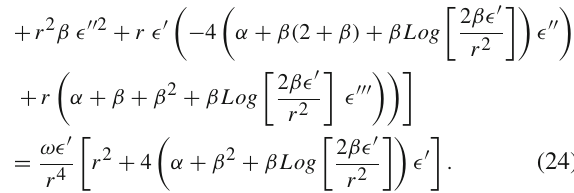
responding regions. It is clear that at the throat ρ < 0, ρ + p r < 0 and ρ + p > 0, but outside the throat ρ > 0, ρ + p t It shows the presence of exotic matter in wormhole geometry